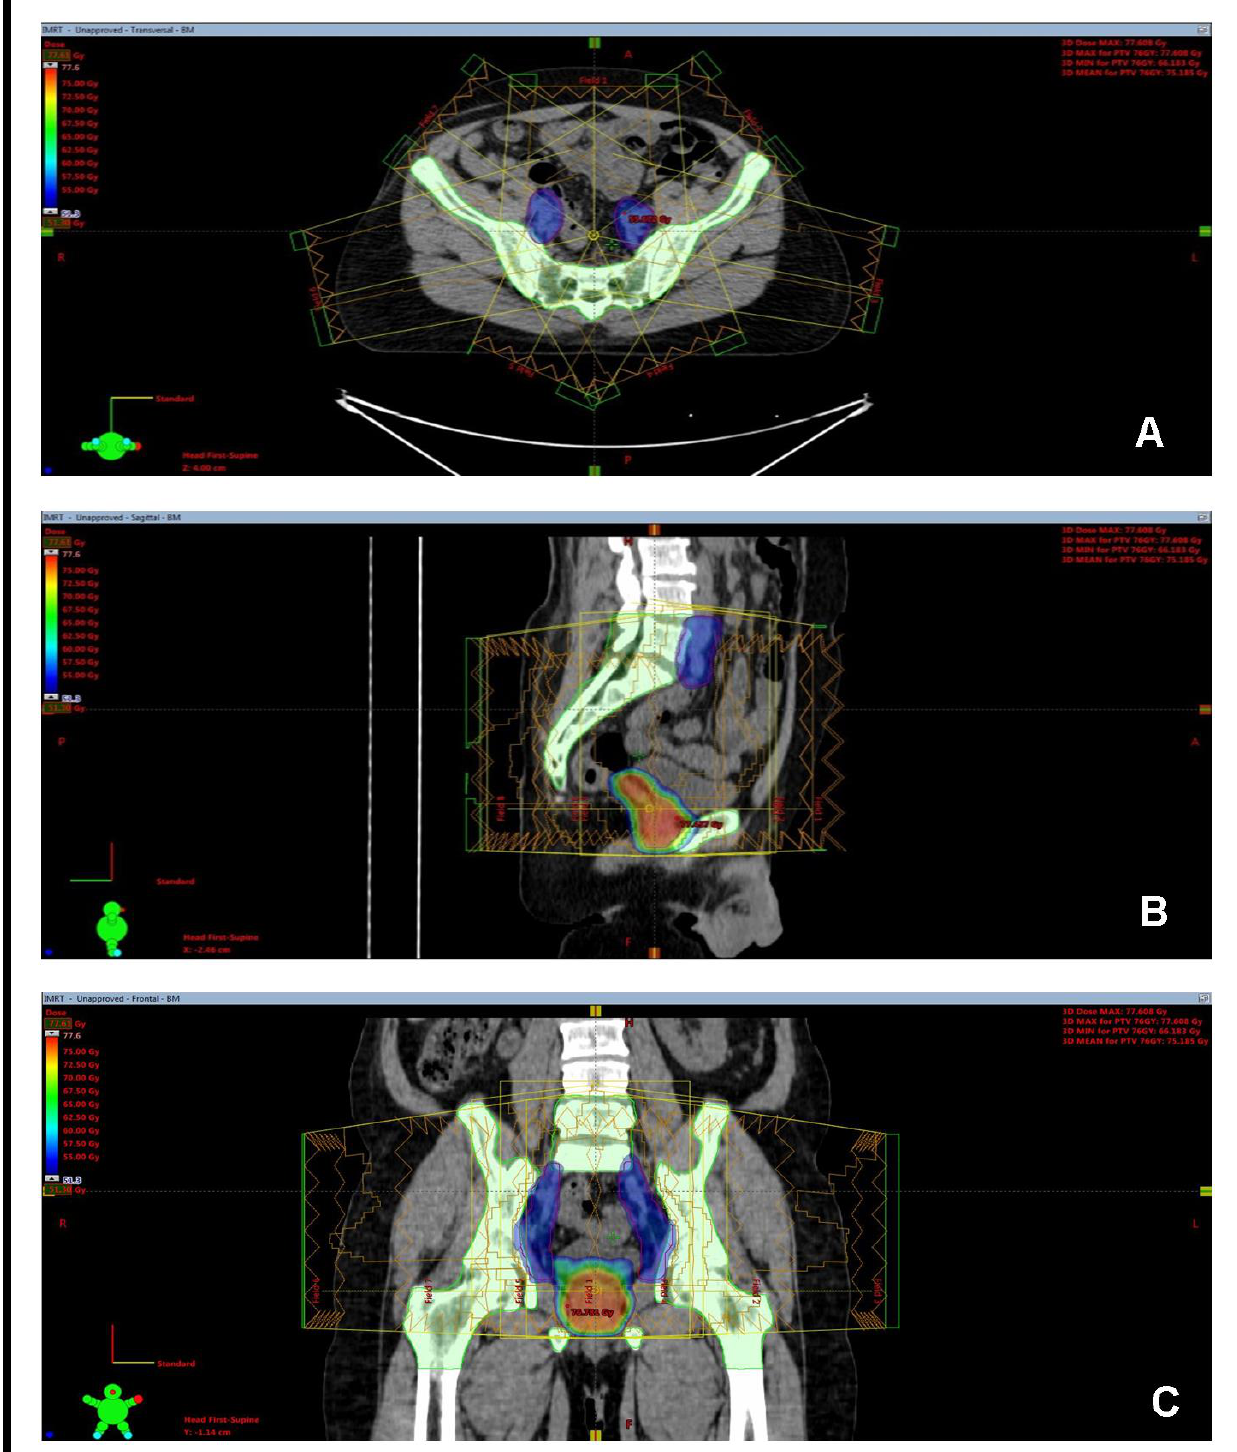
Figure 1: Dose distribution of intensity-modulated radiotherapy (IMRT) plan in one patient: A) Axial, B) Sagittal and C) Coronal